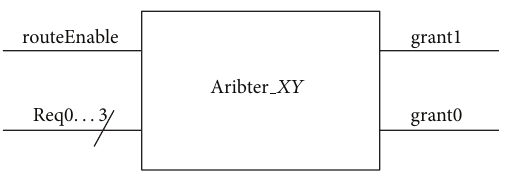
Figure 5: An arbiter with 4 inputs.